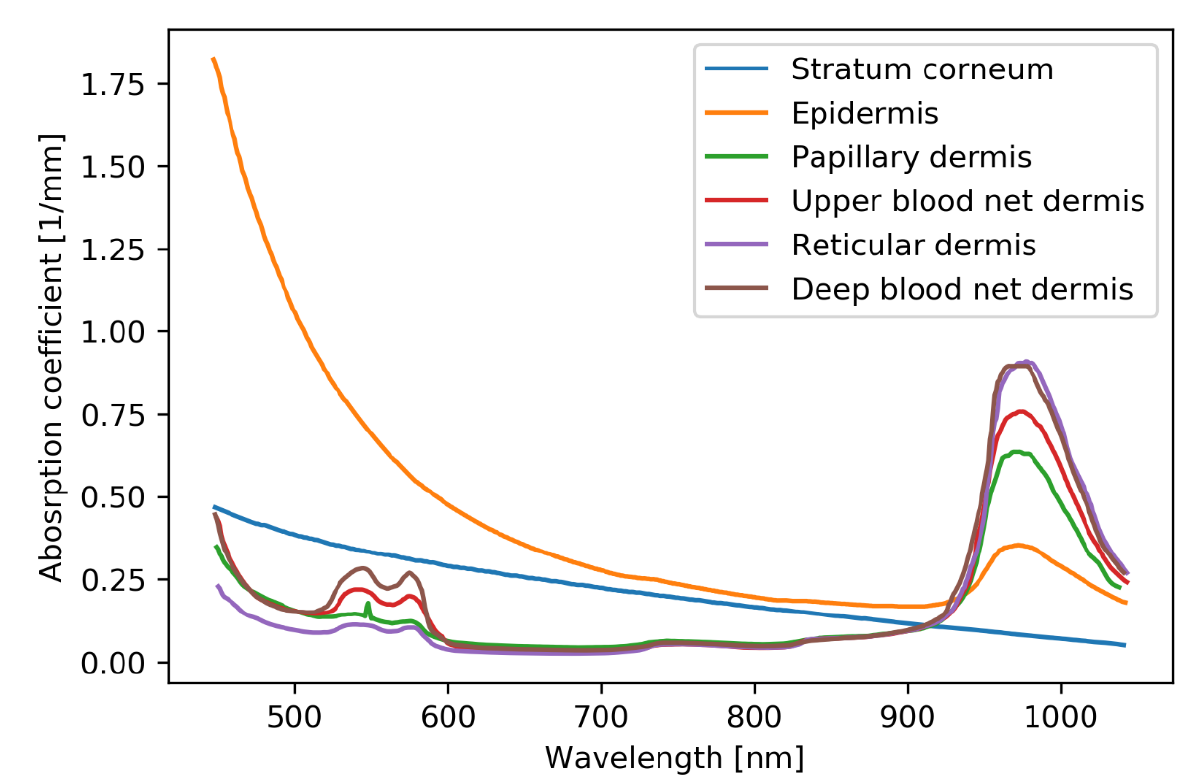
Figure 3. Absorption coefficients of the subdermal layers [23]. Table 3. Blood and water volume fractions used in [23]. Blood Volume Fraction, Water Volume Fraction, Layer V b (%) V wat (%)